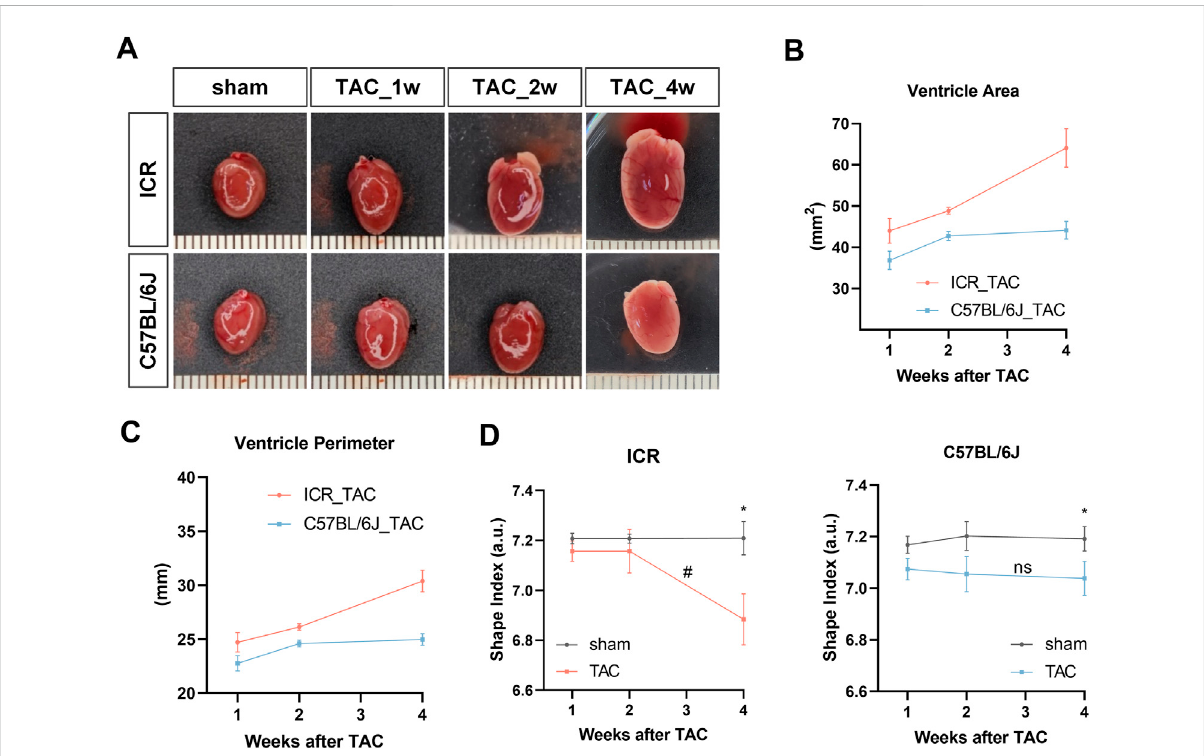
Grosssamplesandshapeanalysesofmouseheartsat1,2and4weekspost-TACorshamsurgeryinICRandC57BL/6Jmice. (A) Representative photosofwholeheart.Scalebaris1 mm. (B) Ventriclearea(leftandrightventricle)and (C) ventricleperimeterobtainedfromheartphotos. (D) Shape index(areaoverperimetersquared).Dataareshownasmean±SEM, N =6perICRgroup, N =6 – 8perC57BL/6Jgroup.* p < 0.05,** p < 0.01vs.their speci fi c sham group. # p < 0.05, ns denotes not signi fi cant compared between 2w and 4w in TAC